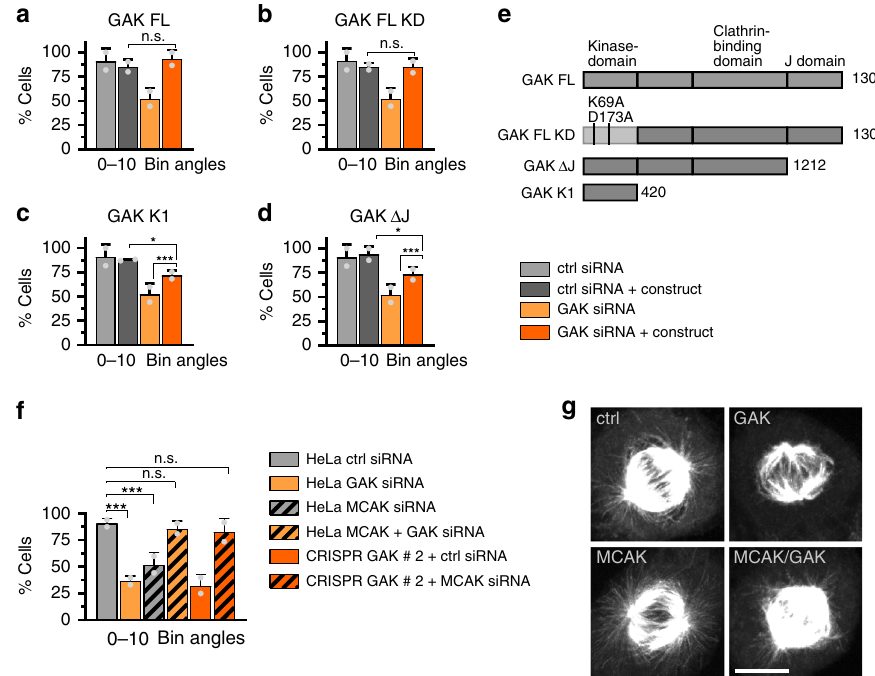
Fig. 6 Function of cyclin G-associated kinase (GAK) in spindle positioning requires J domain. a – f Spindle positioning phenotype of cells grown on fi bronectin-coated coverslips. Shown are mean percentages of cells ±SD with mitotic spindles aligned at 0 – 10° with respect to the surface. a – e Cells treated with ctrl or GAK small interfering RNA (siRNA), as indicated, and expressing one of the GAK constructs shown schematically in e . GAK FL: GAK full-length, GAK FL KD: kinase dead version, GAK Δ J: lacking the J domain, GAK K1: kinase domain only; metaphase angles are reported. Numbers of cells analyzed in two independent experiments each: control siRNA (ctrl): 22, GAK siRNA (GAK): 38, ctrl siRNA + GAK FL: 31, GAK siRNA GAK FL: 21, ctrl siRNA + GAK KD: 44, GAK siRNA + GAK KD: 44, ctrl siRNA + GAK Δ J: 64, GAK siRNA + GAK Δ J: 67, ctrl siRNA + GAK KD: 57, GAK siRNA + GAK KD: 75. Angles were compared between the group ctrl siRNA + GAK construct (dark gray) and the group GAK siRNA + GAK construct (dark orange), as well as GAK siRNA vs. GAK siRNA plus construct ( p , q ) using a Mann – Whitney U test. p = 0.60 ( a ), p = 0.77 ( b ), * p = 0.0143 ( d ), * p = 0.025 ( c ), *** p = 1.6 × 10 − 5 ( d ), *** p = 4.5 × 10 − 5 ( c ), n.s. = non signi fi cant. f Cells treated with ctrl ( n = 23 cells), MCAK siRNA (n = 28 cells), GAK siRNA ( n = 22 cells), MCAK siRNA plus GAK siRNA ( n = 32 cells), GAK CRISPR/Cas9 # 1 plus ctrl siRNA ( n = 31 cells) or GAK CRISPR/Cas9 # 1 plus MCAK siRNA ( n = 31 cells). Results from two biological replicates (mean ± SD); angles distributions were compared using Mann – Whitney U test, *** p = 0.0008: ctrl vs. GAK siRNA, p = 0.0002: ctrl vs. MCAK siRNA, p = 0.5850: ctrl vs. GAK plus MCAK siRNA, p = 0.0699: ctrl vs. GAK CRISPR/CAS9 # 1 plus MCAK siRNA. g Immuno fl uorescence of cells treated with ctrl siRNA, GAK siRNA, MCAK siRNA or both, as indicated, and stained with antibodies against α -tubulin.